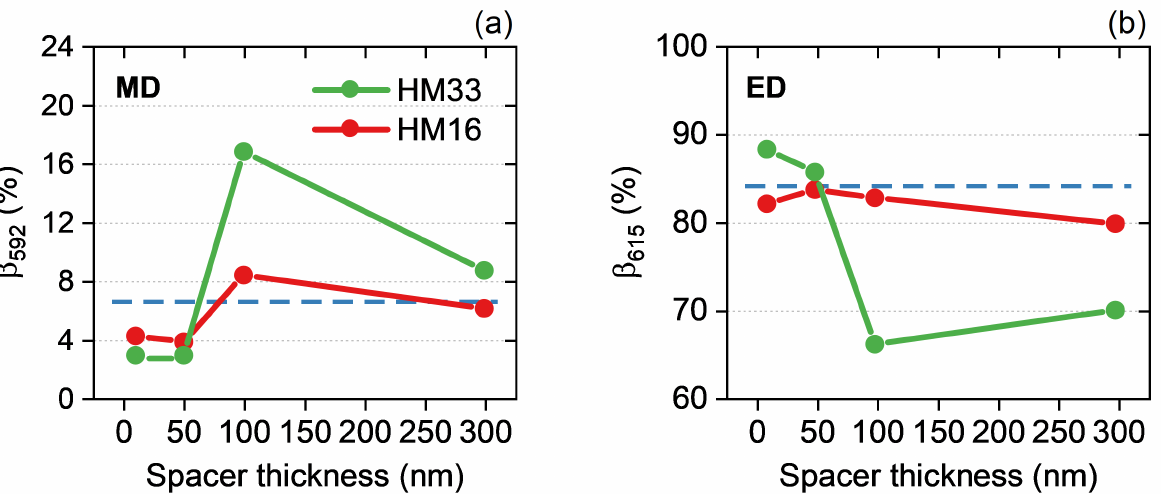
Figure 3. Experimental branching ratio of ( a ) the 5 D 0 → 7 F 1 transition at λ = 592 nm (MD) and ( b ) the 5 D 0 → 7 F 2 transition at λ = 615 nm (ED) calculated as a function of the spacer thickness. The horizontal blue dashed lines represent the BR calculated for each transition with Eu:PMMA deposited on a SiO 2